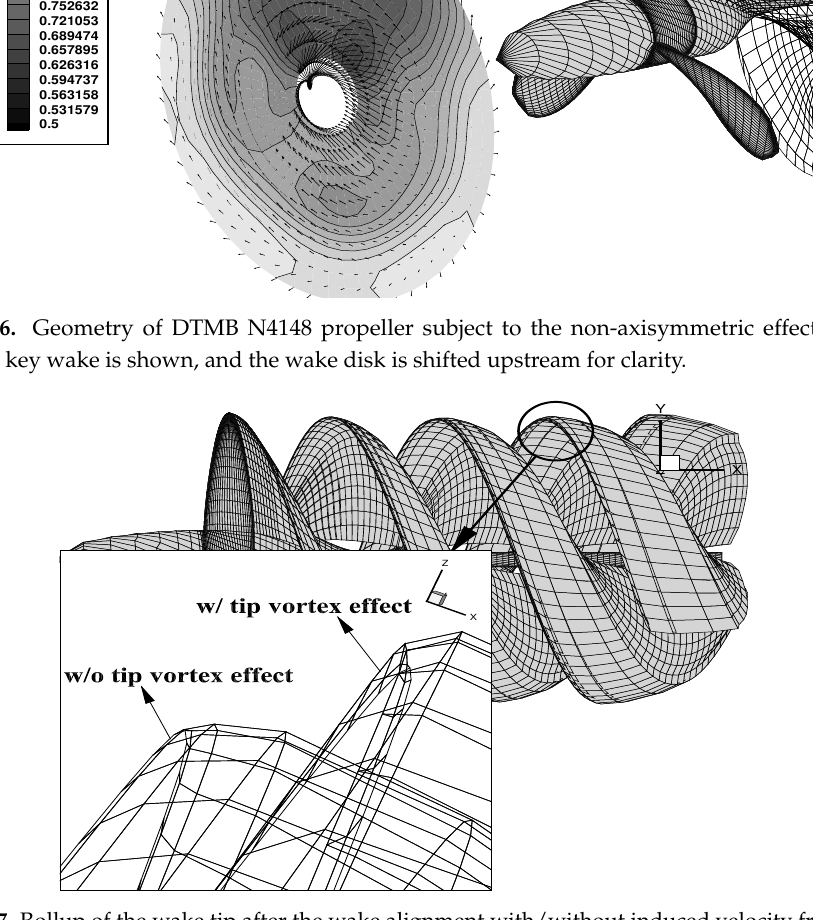
Figure 17. Rollup of the wake tip after the wake alignment with/without induced velocity from the tip vortex cavitation: DTMB N4148 propeller, uniform inflow. Tip cavitation geometry is not presented. The wake geometry w/o tip vortex effect is shifted by − 0.5 in y direction for clarity in the lower